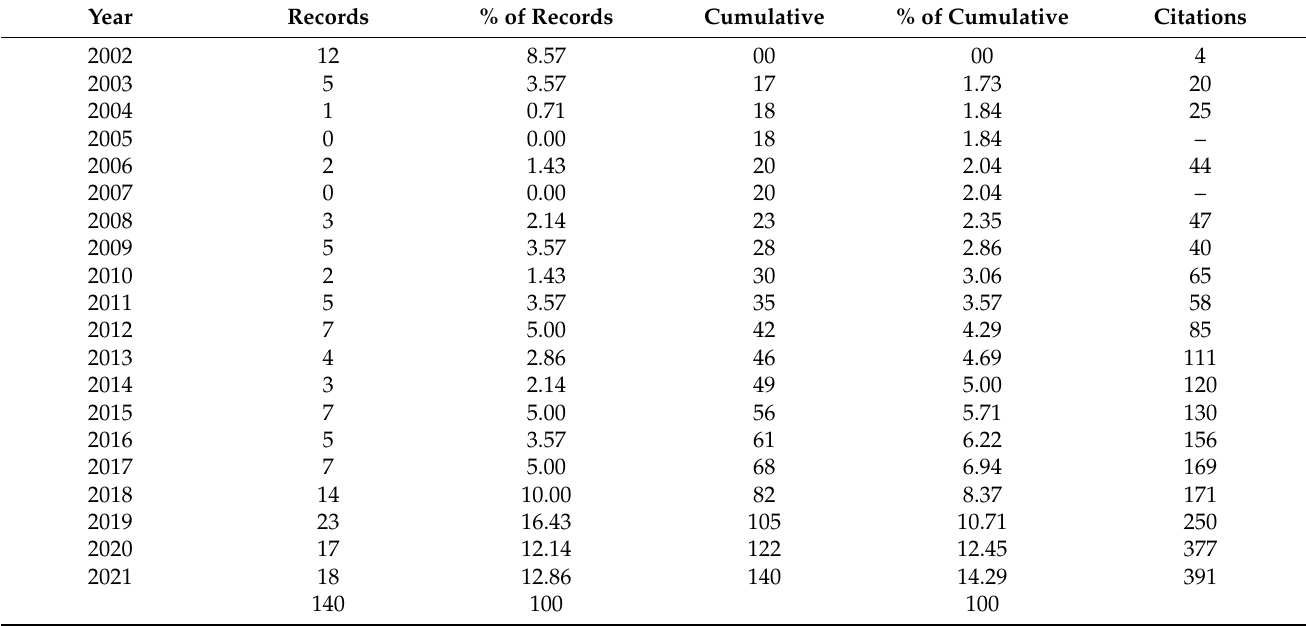
Table 1. Growth of publications and citations of the world output in health sciences